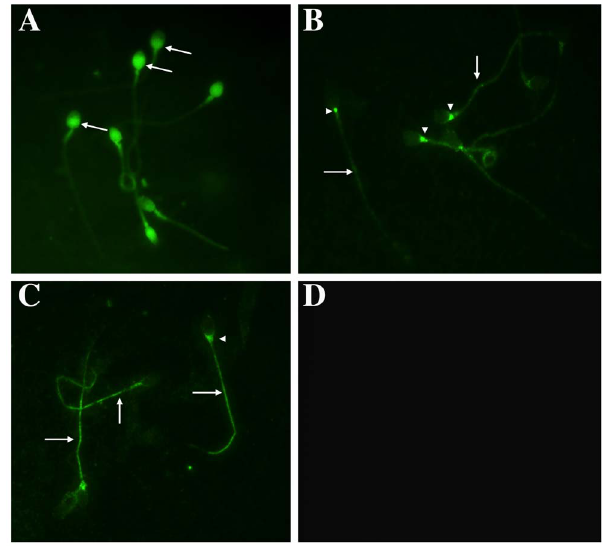
Figure 2. Indirect immunofluorescence of PP1 c , PP2B, and PP2A location in human sperm. Aliquots of sperm selected and re- suspended in NCM were smeared on glass slides, fixed with paraformaldehyde, permeabilized with Triton X-100, and treated overnight with specific anti phosphatase antibodies. Then, samples were treated with Alexa Fluor H 633-conjugated anti-rabbit immuno- globulin or Alexa Fluor H 555-conjugated anti-goat immunoglobulin. (A) Presence of PP1 c ; (B) Presence of PP2B; (C) Presence of PP2A; and (D) negative control. Each micrograph (600 6 ) is representative of three replicates in each of which at least 100 sperm were analyzed.